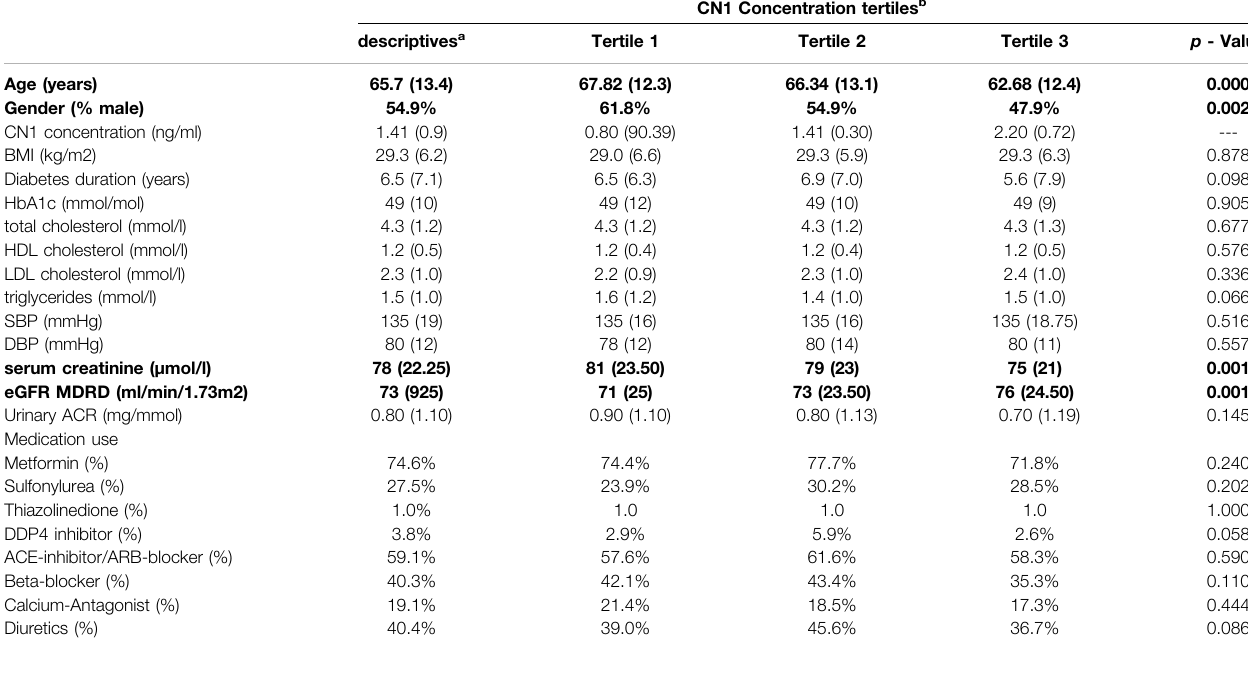
TABLE 1 | Baseline characteristics and CN1 concentration